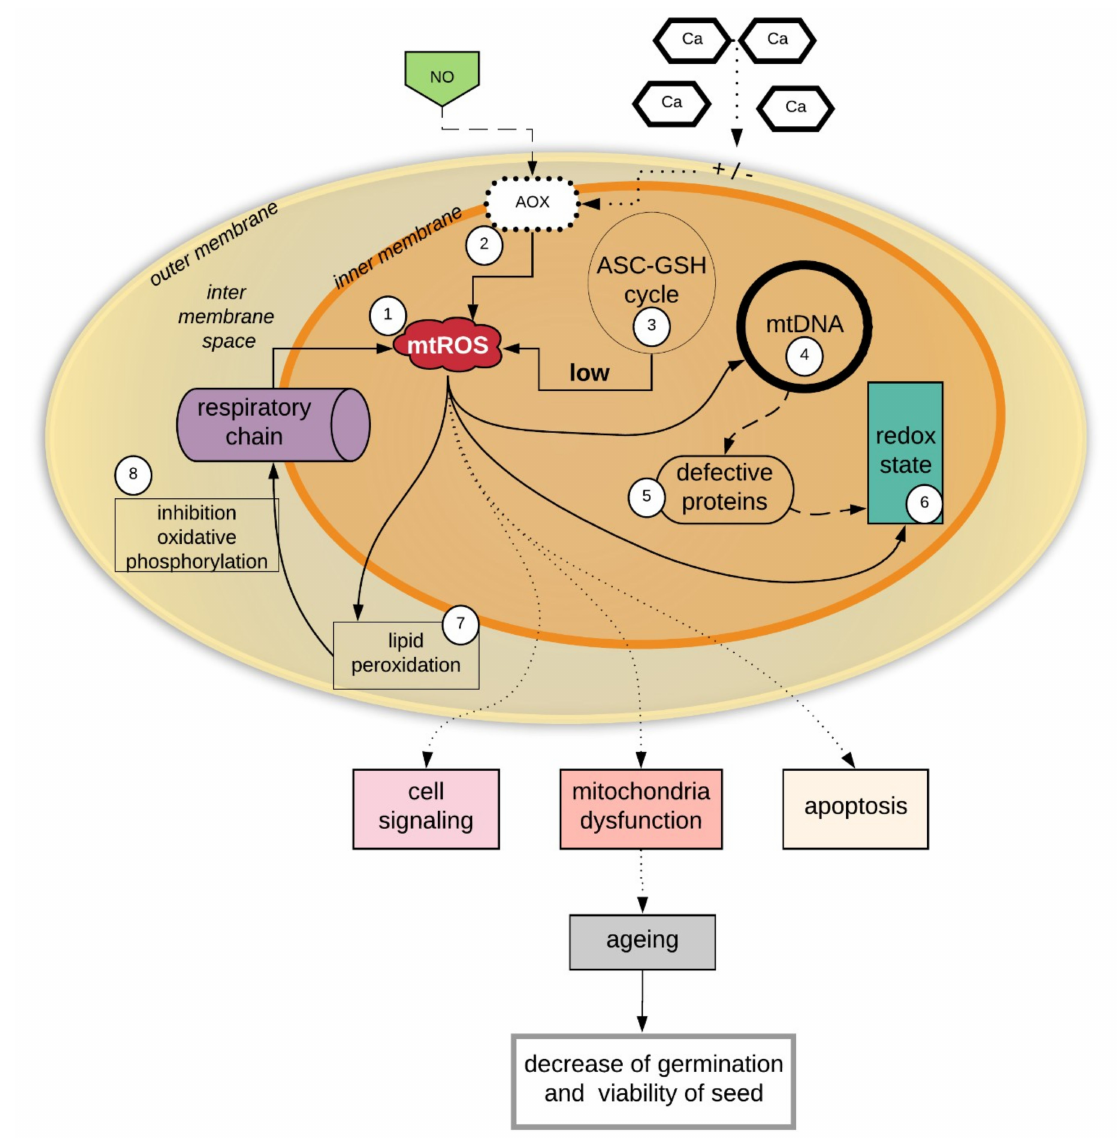
Figure 1. Dysfunctional mitochondria and aging of seeds. Due to continuous reactive oxygen species (ROS) production in mitochondria, the level of ROS increases during seed storage (1). The nitrogen oxide (NO) influence on alternative oxidase (AOX) (2), which cause ROS generation (2). Calcium ions change membrane potentials and are also influenced by AOX (2) on the increase of ROS level in mitochondria. The ascorbate-glutathione cycle (3) does not effectively remove ROS (3), which causes oxidative damage to mtDNA (4) and protein synthesis (5) and leads to changes in signaling and the redox status in the mitochondria (6). Increasing ROS levels (7) in the mitochondria cause oxidative damage to the membranes (7), which affects the inhibition of oxidative phosphorylation (8). All of these events cause a decrease in seed viability and show the basis of aspects of seed aging. Solid arrows shows the process that happened in ageing seeds, the doted arrows explain in which processes ROS participate, detailing processes of ageing and decrease of germination and viability of